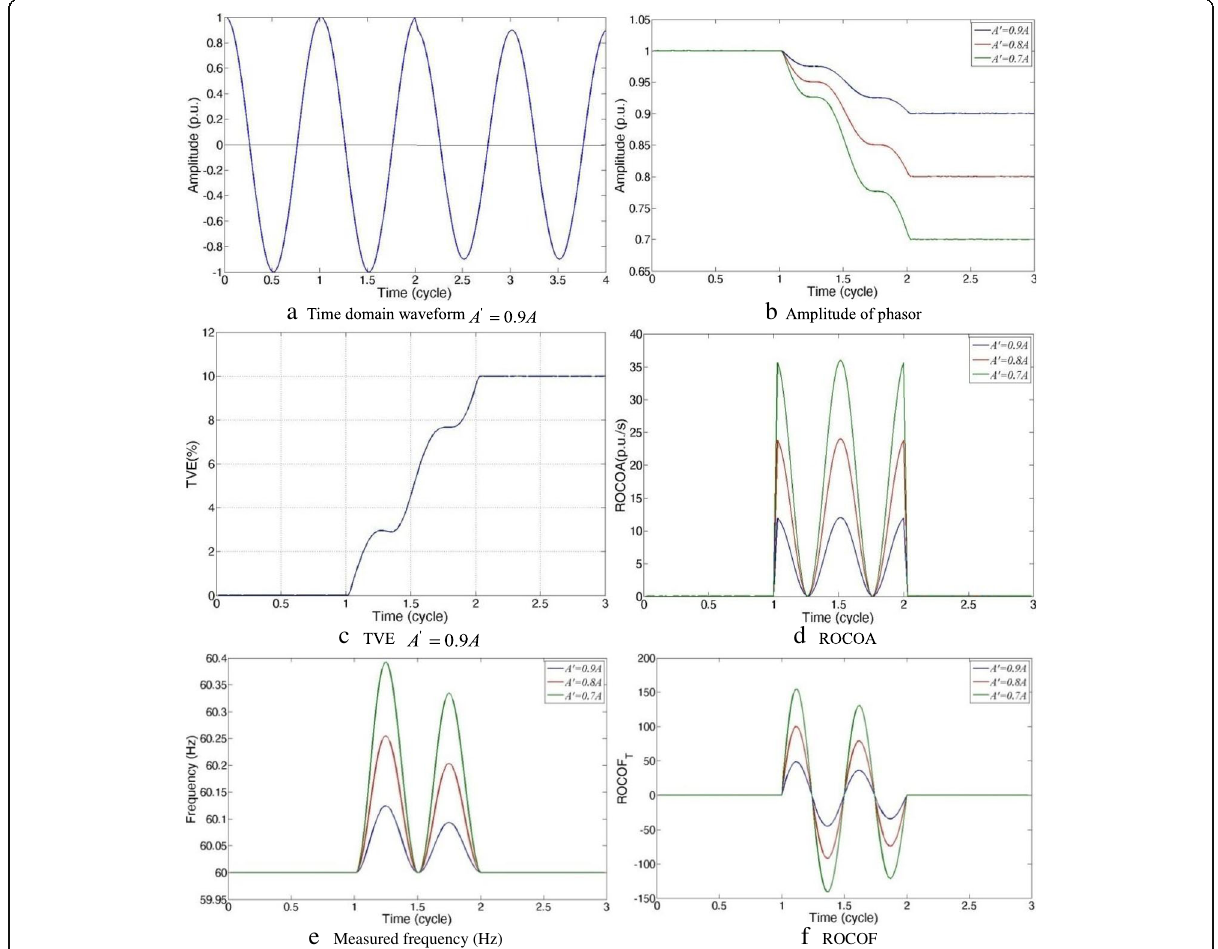
Fig. 6 Amplitude step change scenarios (step change occurs at the beginning of the second cycle; A = 1 p.u., f 0 = 60 Hz, φ 0 =